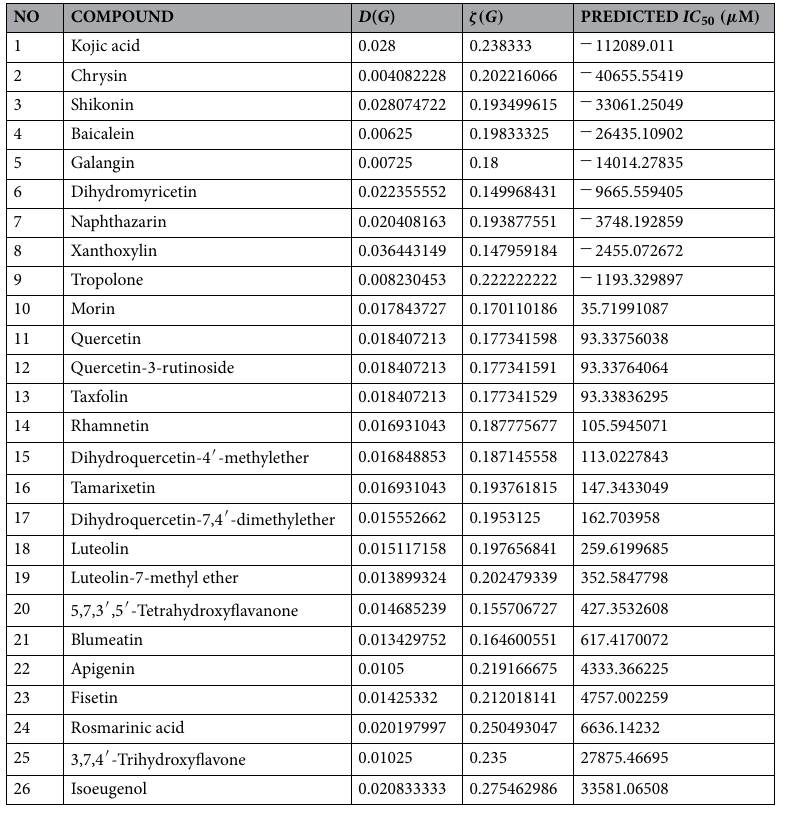
Table 2. 26 Flavonoids - rank order of